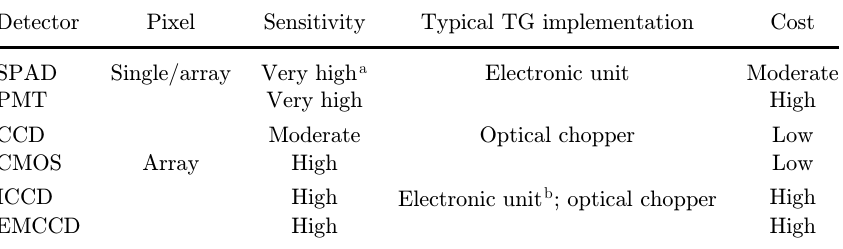
Table 2. Comparison of detectors for TG imaging.